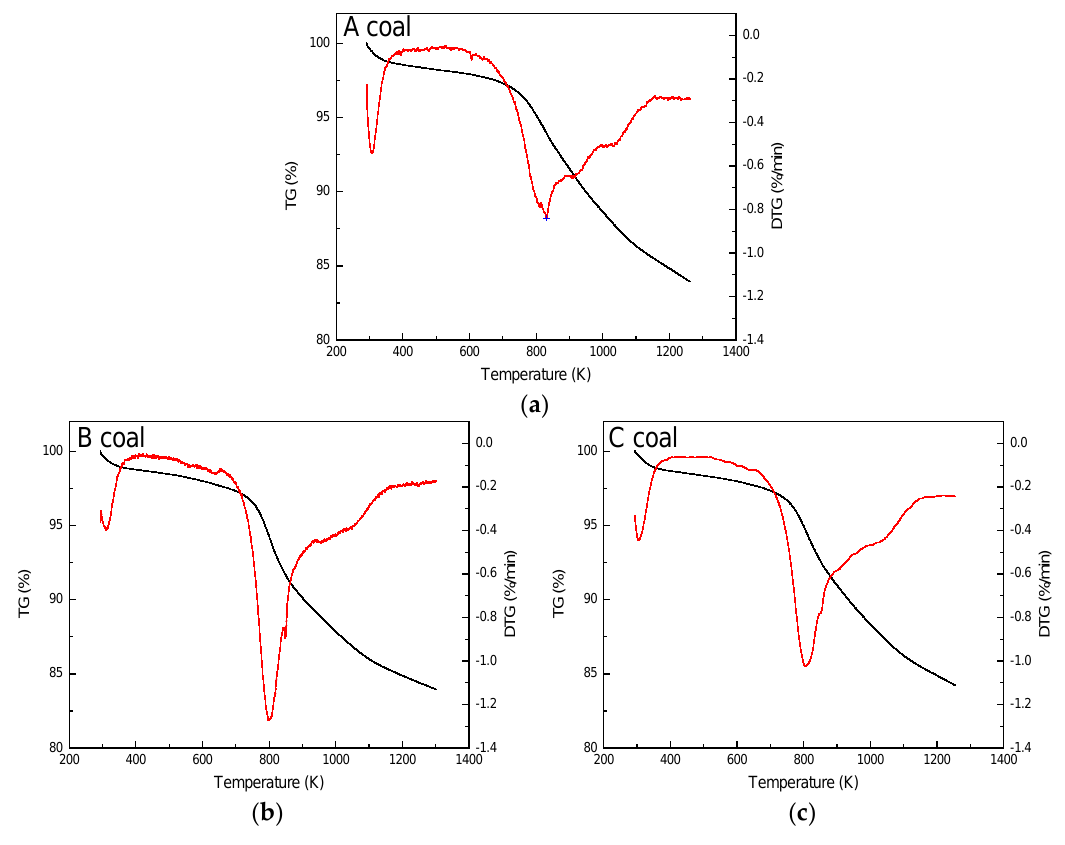
Figure 1. Pyrolysis behaviors of A coal ( a ), B coal ( b ) and C coal ( c ). Table 2. Characteristic parameters of pyrolysis behaviors.